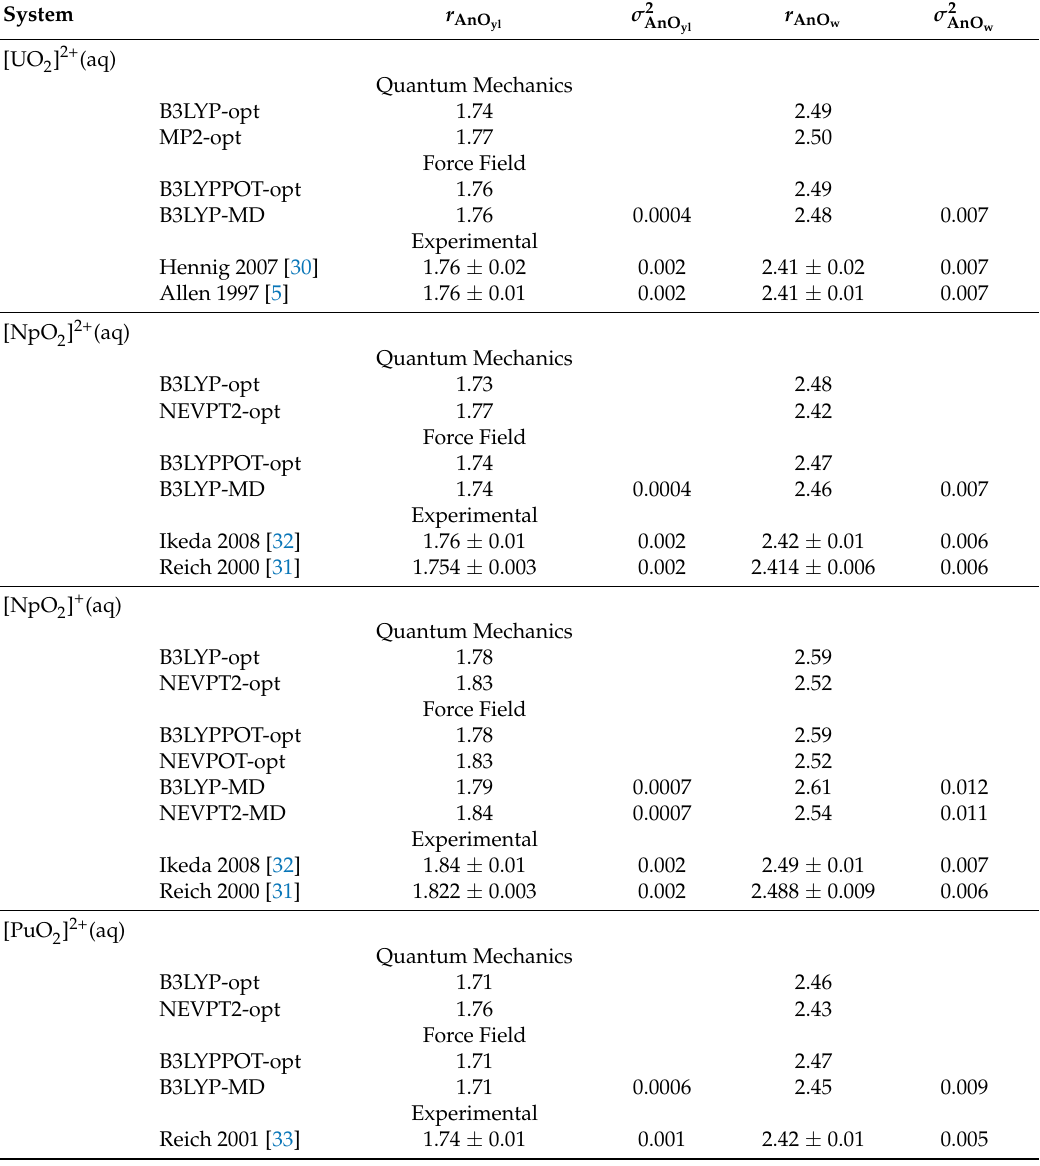
2 ). r AnO σ 2 σ 2 AnO yl AnO w w yl